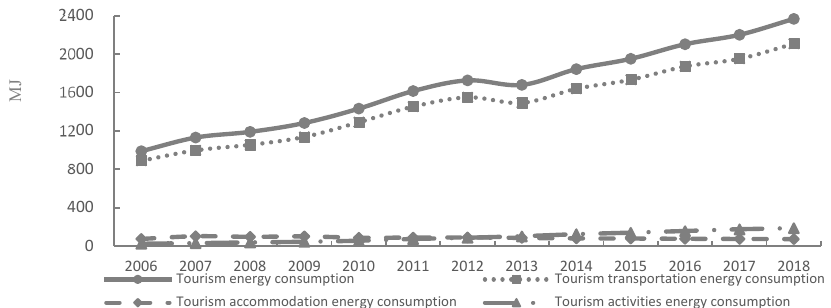
Figure 2. The estimated consumption of energy in tourism industry in China, 2006 to 2018. Note: Data is calculated and processed from this